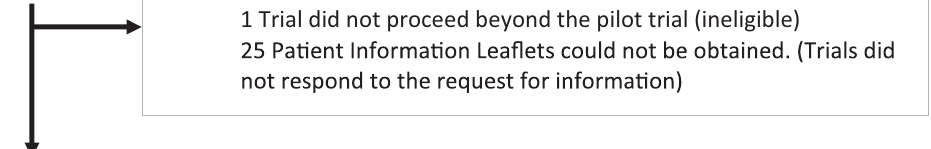
Fig 1. Identification of a cohort of